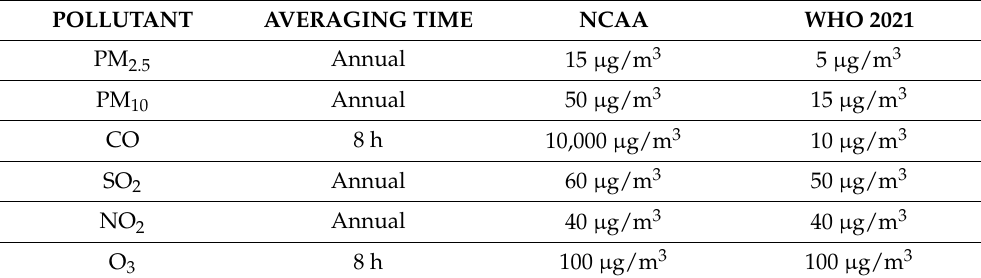
Table 1. Comparative table of permissible values for pollutants according to NCAA and WHO. POLLUTANT AVERAGING